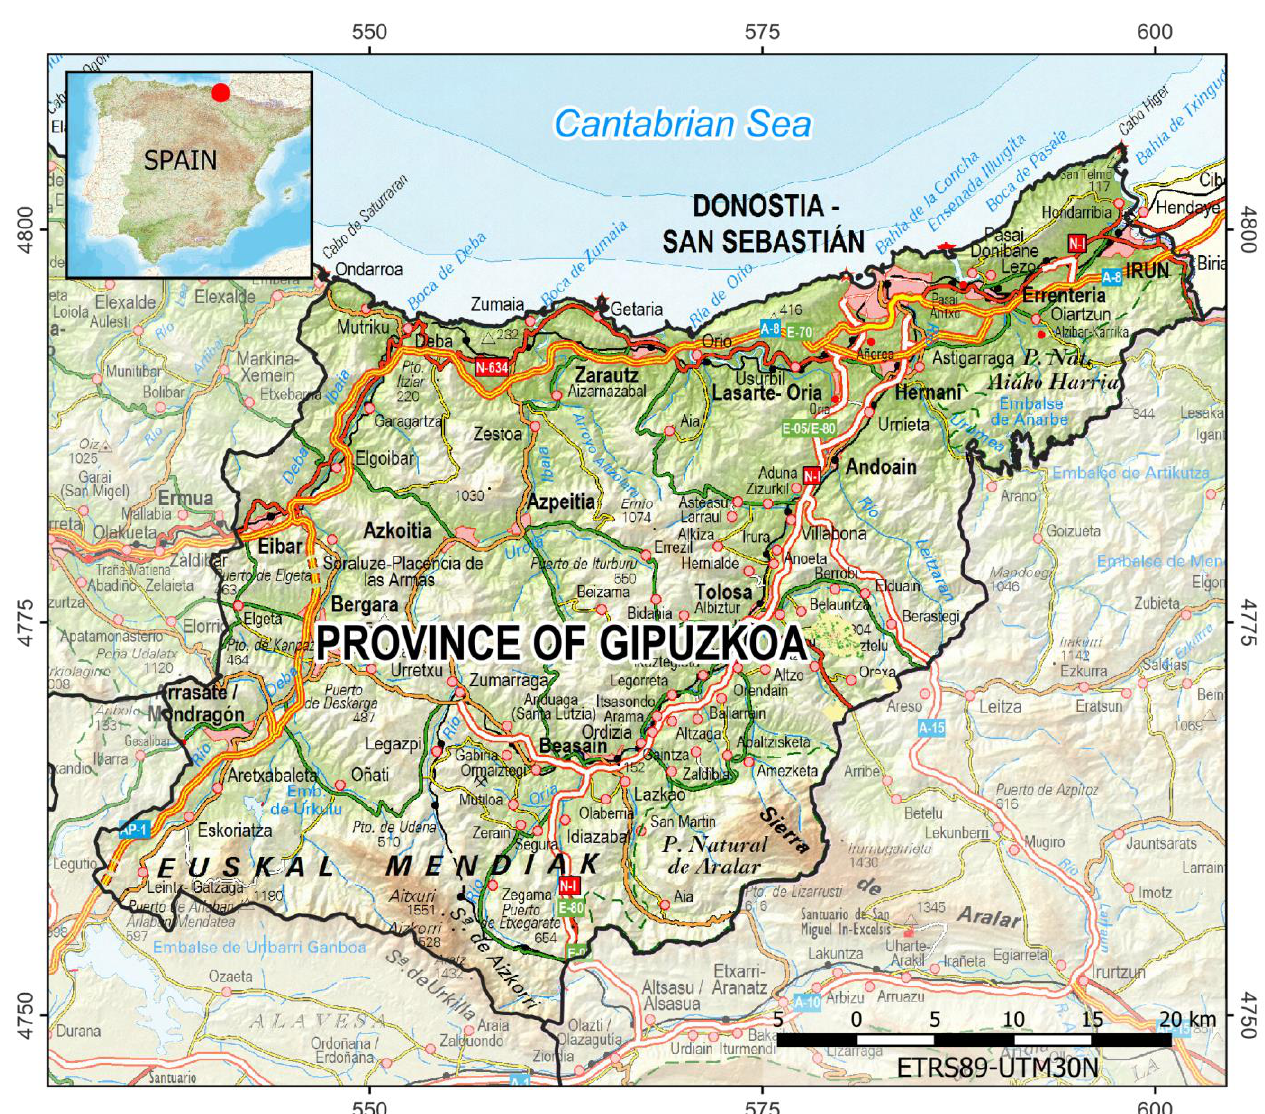
Figure 1. The geographical extent of the research (province of Gipuzkoa, Spain). Source: Own elaboration from www.ign.es (accessed on 22 November 2022). Frame coordinates in km.